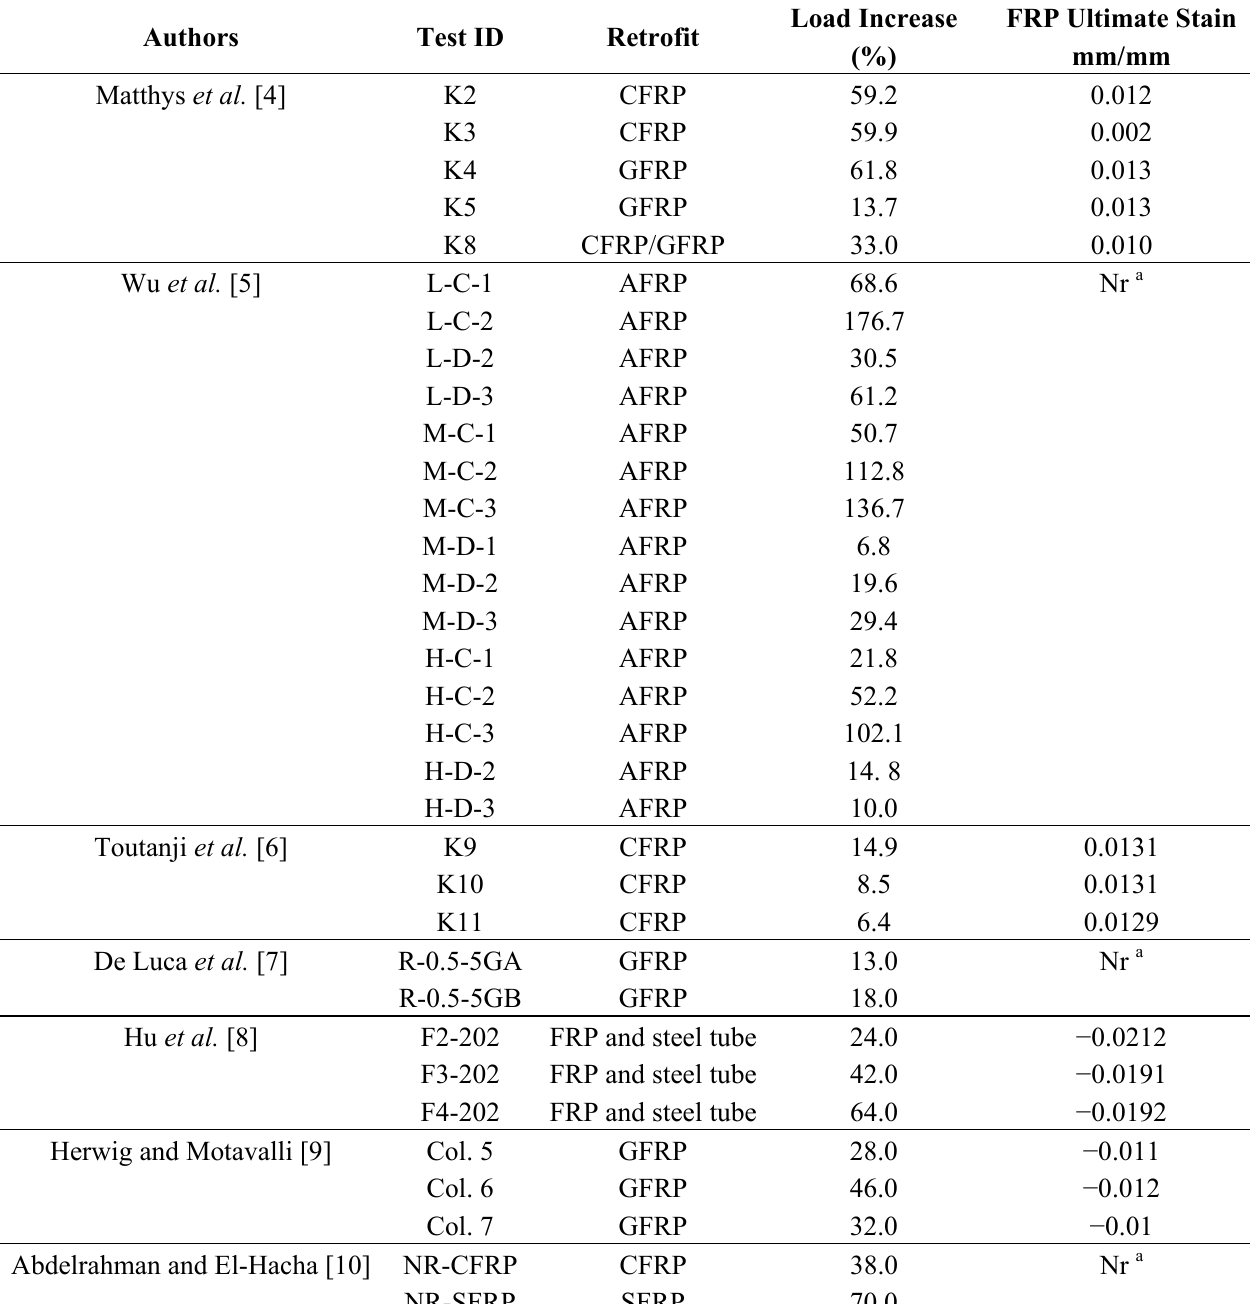
Table 1. Representative experimental data on fiber reinforced polymers (FRP)-retrofitted axially loaded columns. Final mode of failure for all specimens was the FRP